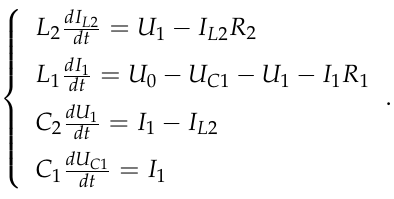
Figure 6. Mathematical calculation of the equivalent excitation circuit structure.